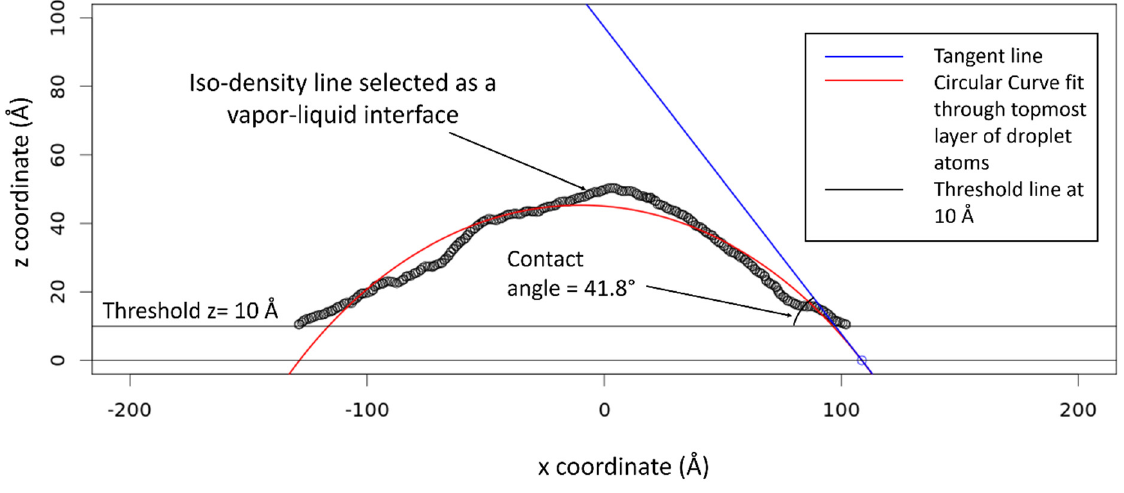
Figure 14. Determination of the contact angle value by fitting an equation of a circle through the topmost layer of monomer droplet atoms.